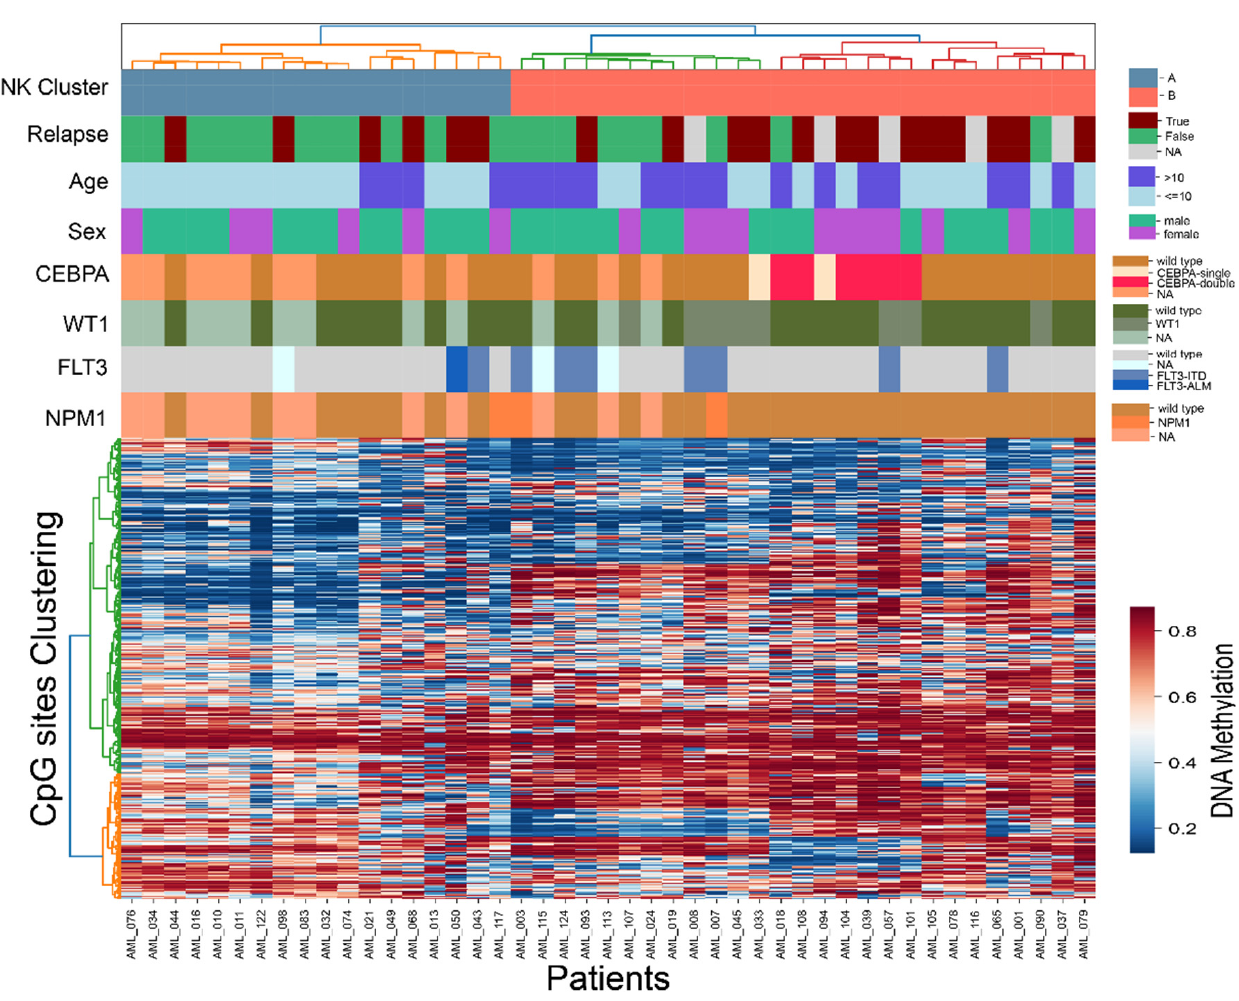
Figure 3. Heatmap and hierarchical clustering of the 45 NK samples across 1300 CpG sites, including 30 cytogenetically defined (diagnostic-known) patients and 15 DNA methylation predicted NK patients. Each row in the heatmap denotes a CpG site and each column is a patient. The labels at the top of the heatmap represent clinical and molecular features of interest, including the Cluster denotation A and B.